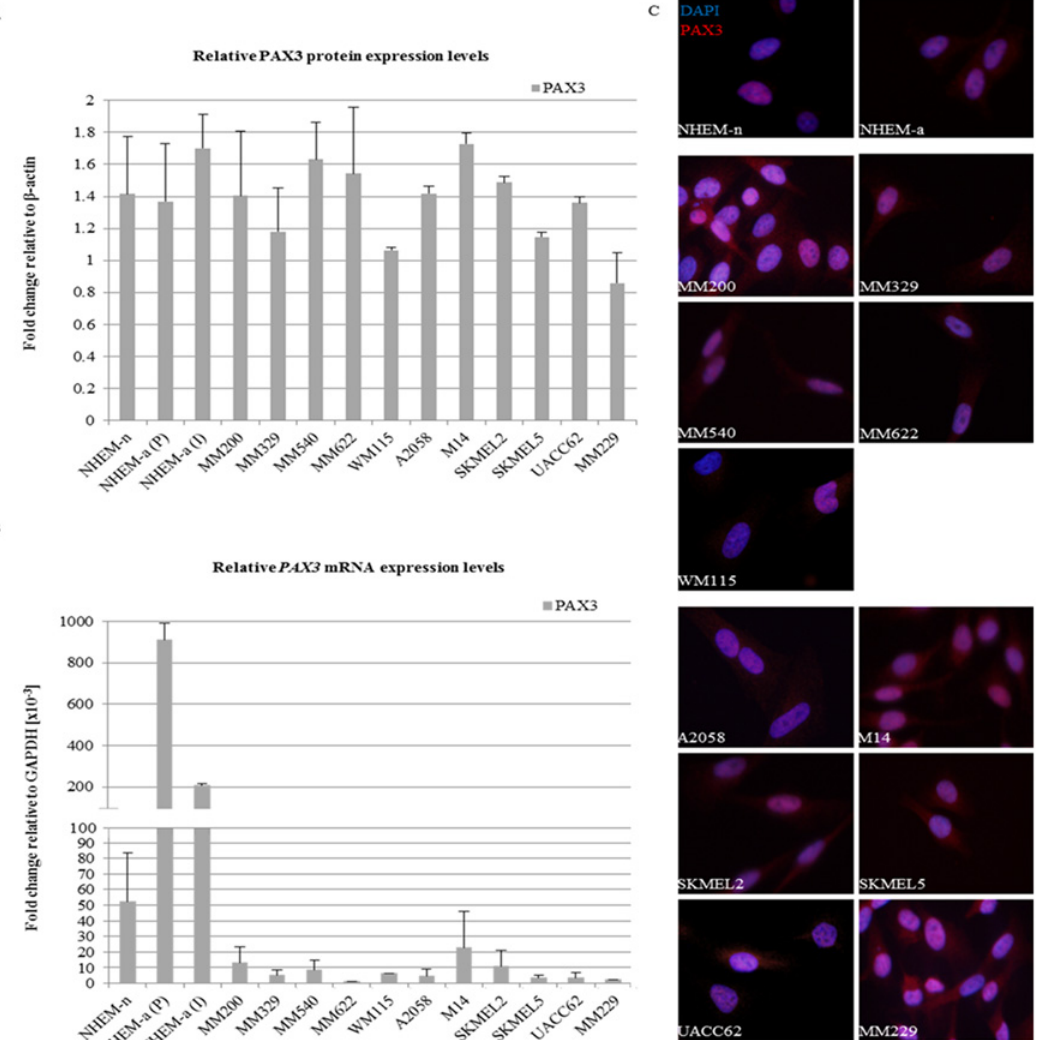
Fig 3. PAX3/ PAX3 expression in a representative panel of melanocytes and melanoma cell lines. A) PAX3 protein levels relative to β -actin. Each sample was run in duplicate on separate gels and the density of each band was assessed by densitometric scanning using the GS-800 Calibrated Densitometer (Bio-Rad). The density of each PAX3 band was compared to that of β -actin for each lane on the same membrane and the fold change calculated and graphed. The error bars represent the standard deviation between duplicate samples. B) PAX3 mRNA expression in neonatal and adult normal human epidermal melanocytes and primary and metastatic melanoma cell lines. RT-qPCR was performed using RNA from neonatal (NHEM-n) and adult (NHEM-a (P) and NHEM-a (I)) human epidermal melanocytes as well as six primary (MM200, MM229, MM329, MM540, MM622 and WM115) and five metastatic (A2058, M14, SKMEL2, SKMEL5 and UACC62) melanoma cell lines. The level of PAX3 expression was calculated as fold-change relative to GAPDH expression levels. All PCRs were performed in triplicate and average values were used to calculate fold change over GAPDH for each sample. All samples were run in biological duplicates and the error bars represent the standard deviation of the biological replicates. C) Immunocytochemistry of neonatal and adult human epidermal melanocytes, five metastatic melanoma cell lines and six primary melanoma cell lines. Nuclear PAX3 protein expression (red) is observed in all melanoma cell lines and primary melanocytes. Cell nuclei are stained with DAPI (blue). The scale measures 100 μ M. A negative control was included with each experimental run and proved negative in each instance.